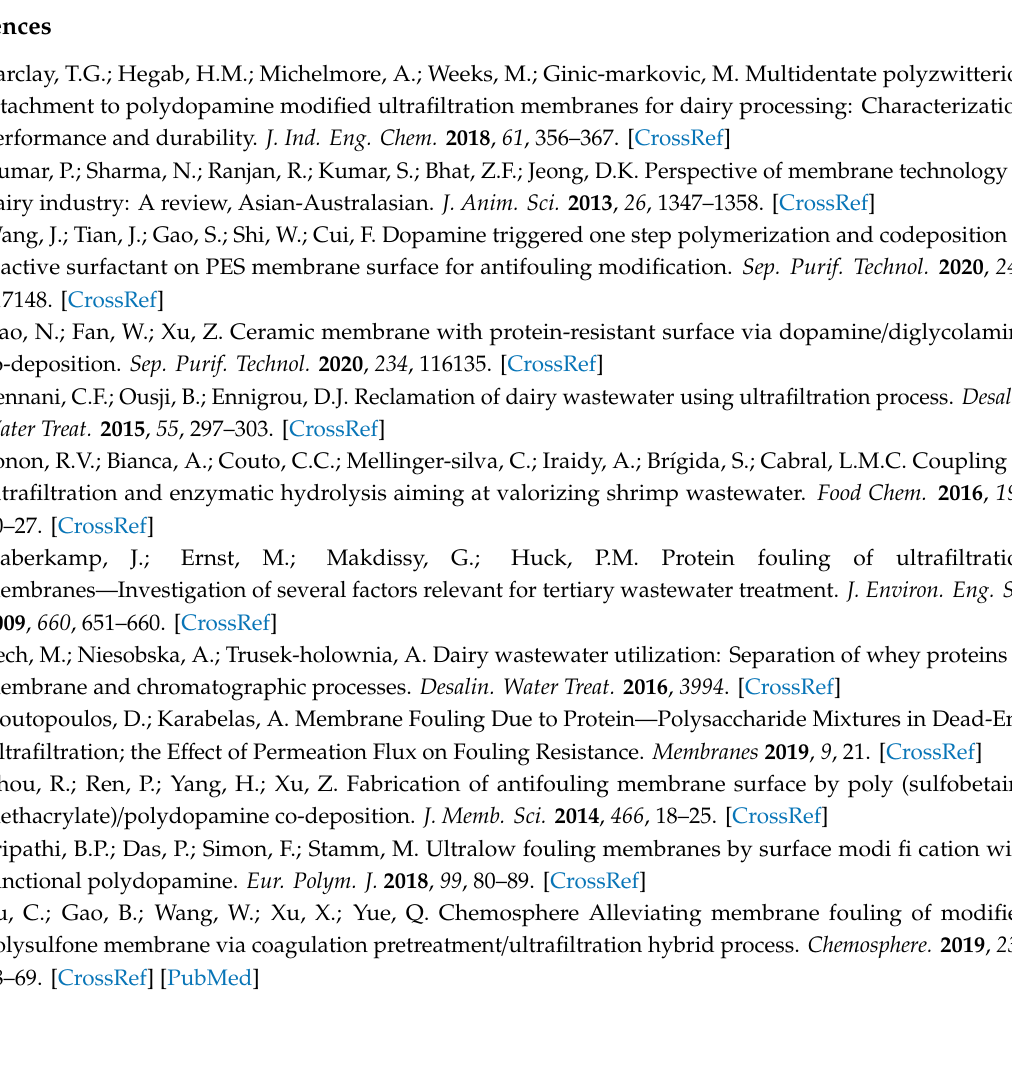
Figure S1: AFM images of the control and modified membranes, Figure S2: Static adsorption test of BSA on the surface of the control and modified membranes. The test was performed for 6 h with a BSA solution concentration of 0.5 g L − 1. Bars with di ff erent letters show statistical di ff erence (p < 0.05), Figure S3: Zeta potential of the control and modified membranes. The DA and PEI concentrations used to modify the membranes were 0.5:4.0 and 0.5:8.0 mg mL −